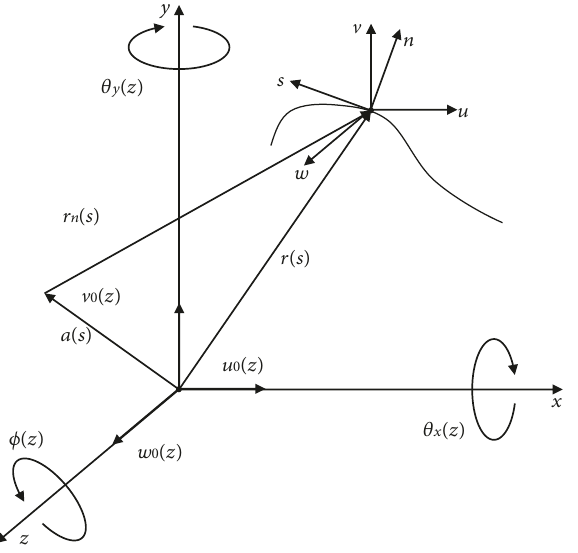
Figure 3: The coordinate system.